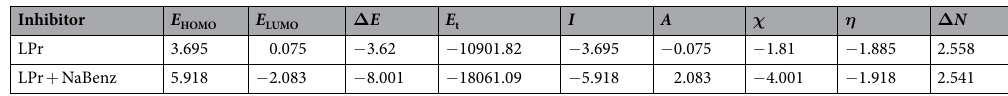
Table 8. The calculated quantum chemical parameters for studied inhibitors obtained using DFT at the B3LYP def2-SVP basis